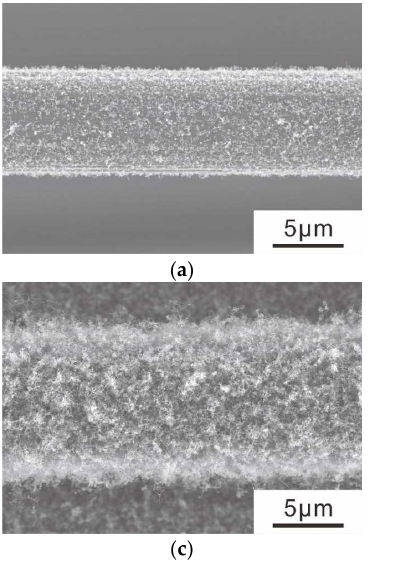
Figure 15. FE-SEM images of ( a ) D-CNT 10 -CF, ( b ) P-CNT 10 -CF, ( c ) D-CNT 30 -CF and ( d ) P-CNT 30 -CF.